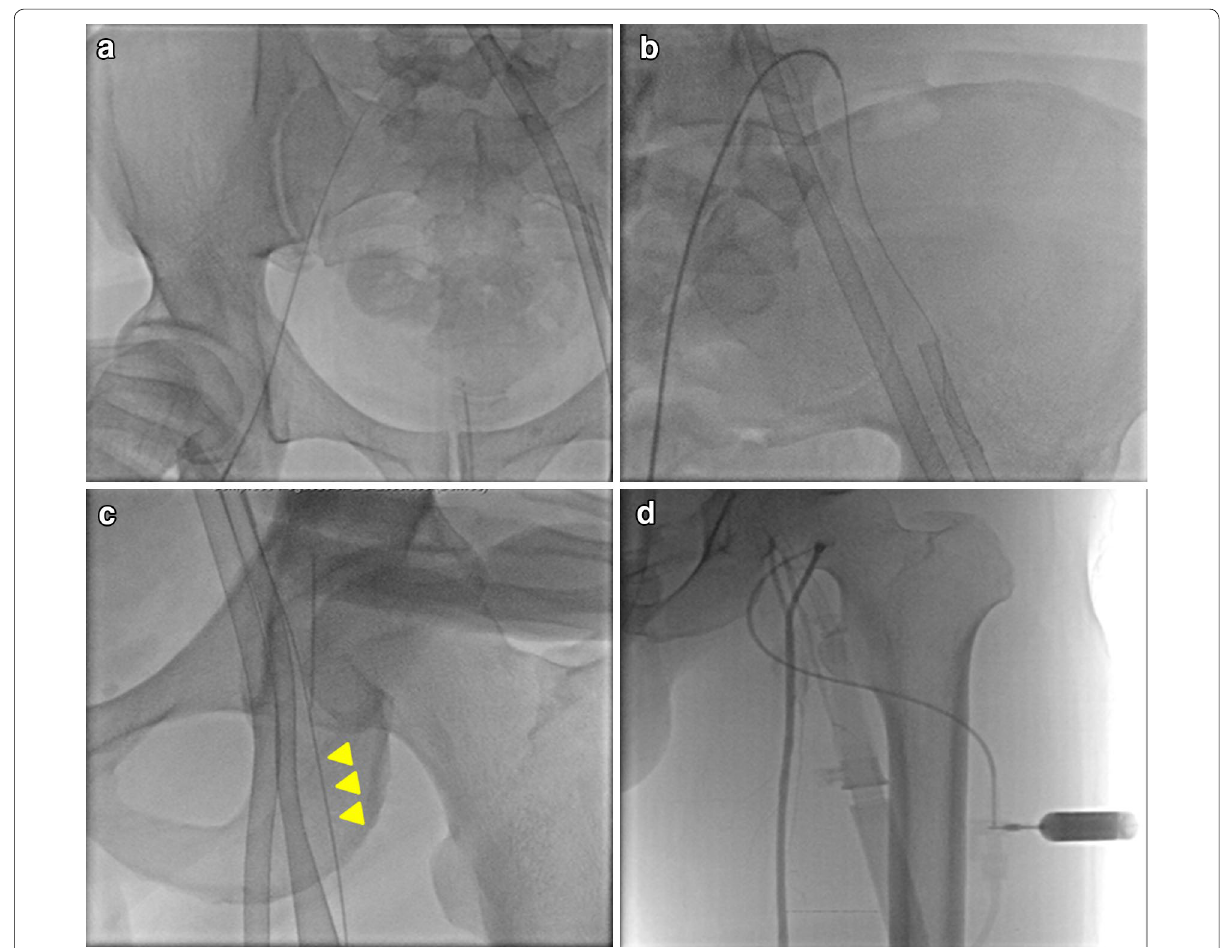
Fig. 2 Percutaneous insertion of a distal perfusion catheter. a Under fluoroscopy guidance, a sheath at the contralateral common femoral artery (CFA) was inserted using a micropuncture needle followed by a 0.018‑inch nitinol wire. b A hydrophilic wire was advanced from the sheath of the contralateral CFA (through the aortic bifurcation and the ipsilateral common iliac artery, between the arterial ECMO cannula and the vessel wall of the ipsilateral common iliac artery) to the distal portion of the ipsilateral superficial femoral artery (SFA). c The proximal SFA ipsilateral to the arterial cannula was punctured using a micropuncture needle followed by a 0.018‑inch nitinol wire as the reference point of the previously placed wire (yellow arrow heads). A distal perfusion catheter (6‑ or 7‑Fr. sheath) was inserted antegrade and advanced safely into the mid‑SFA. d The